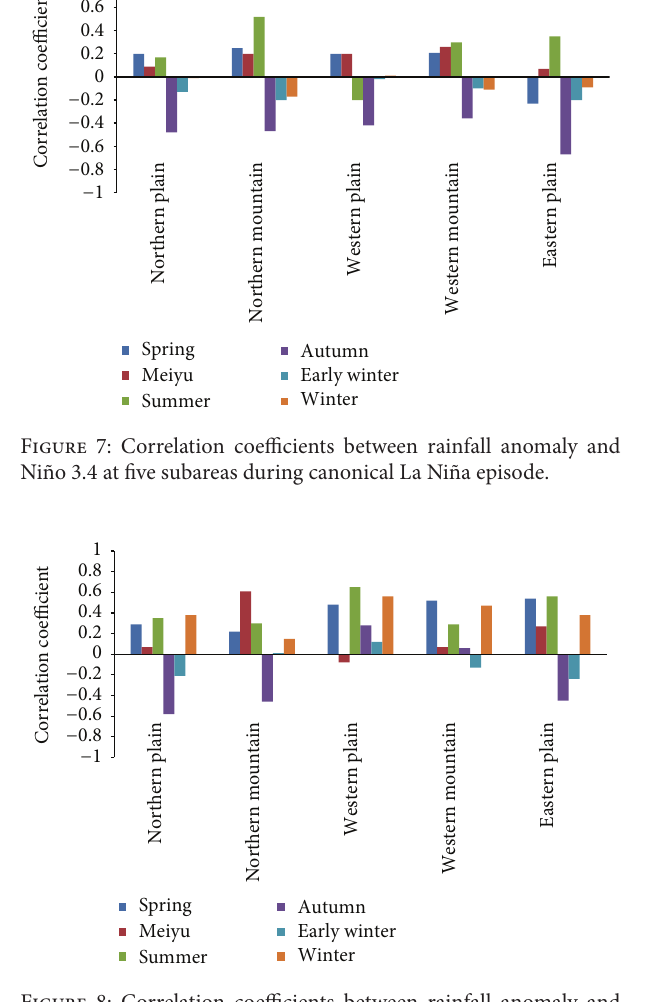
Figure 8: Correlation coefficients between rainfall anomaly and EMI at five subareas during La Ni˜na Modoki